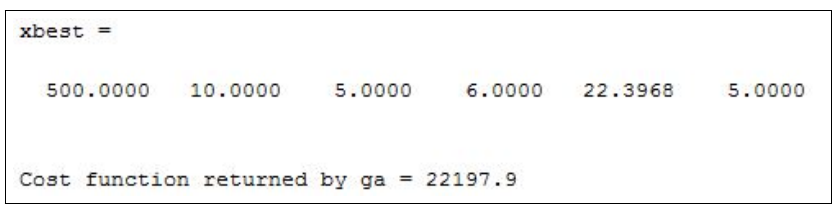
Figure 9. Variations of ACS during GA optimization process for microgrid without diesel generator.